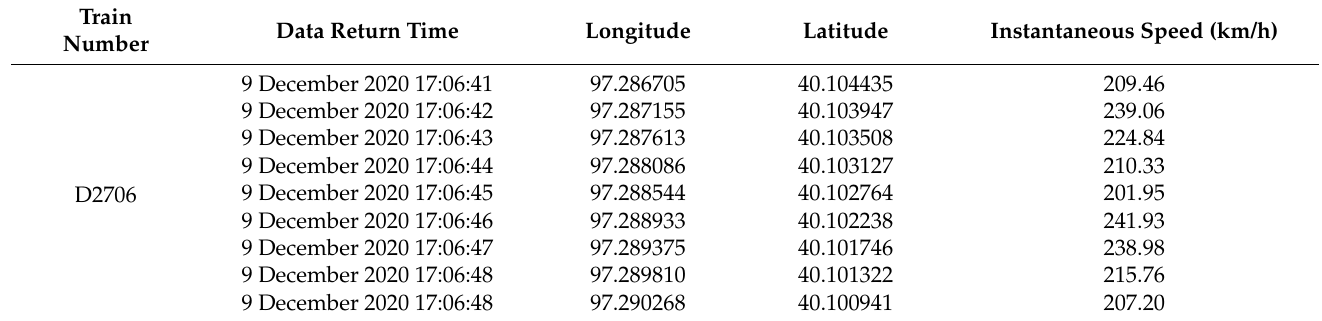
Table 1. Running speed of